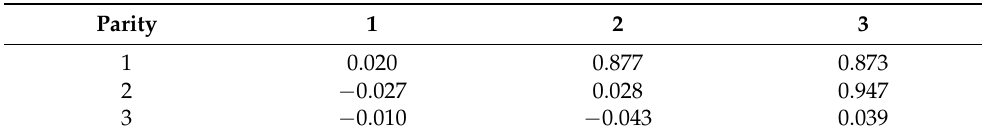
Table 3. Genetic correlation (upper diagonal) and phenotypic correlation (below diagonal), heritability (diagonal) per parity.